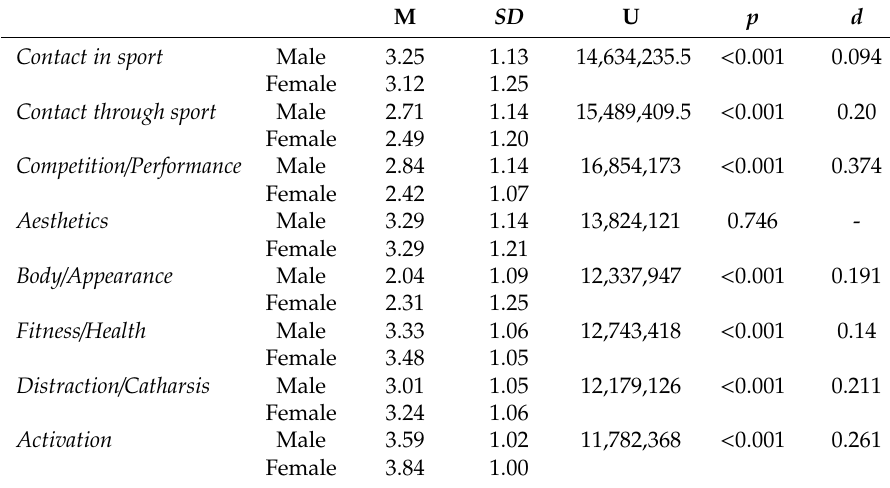
Table 6. Comparison of motive mean values across